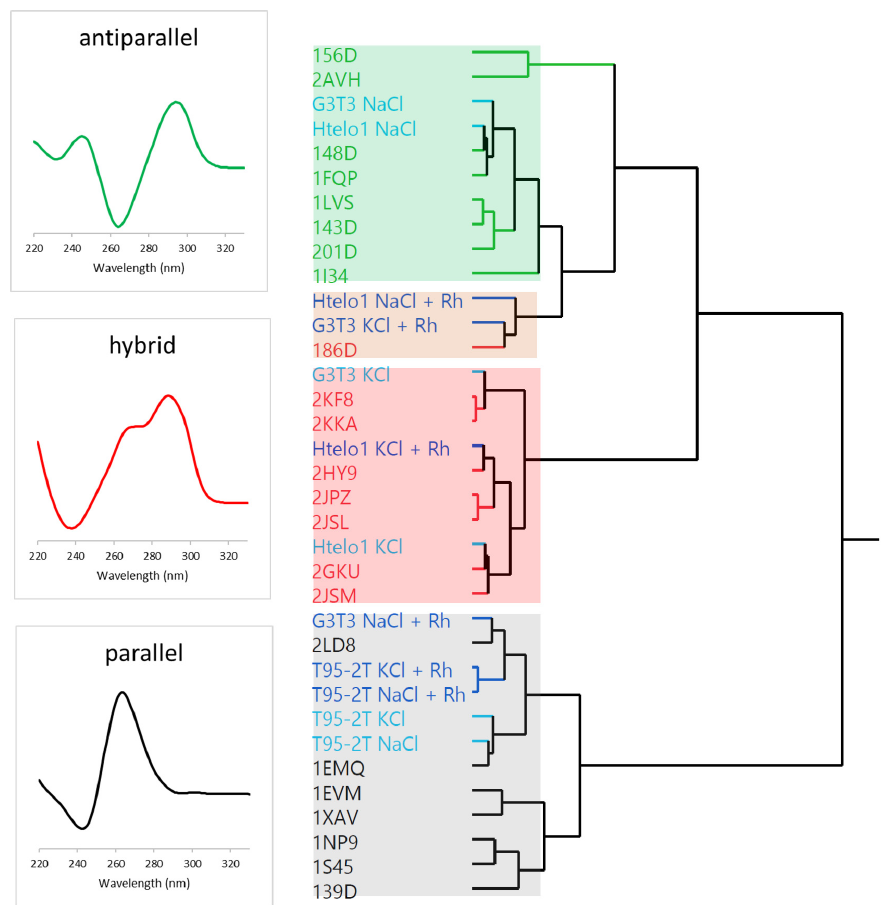
Figure 7. Hierarchical cluster analysis on the CD spectra of experimental samples, eval- uated with reference spectra from [35]. The dendrogram on the right indicates three main clusters, comparable to those found with PCA analysis illustrated in Figure 6. For each cluster, a typical associated CD reference spectrum is shown, indicating antiparallel, “hybrid”, and parallel G4 topologies, respectively. A further cluster highlighted in amber color includes the spectra of intermediate characteristics. Cluster analysis was obtained according to Ward’s minimum variance method using the data of the most distinctive spectra interval of 250–300